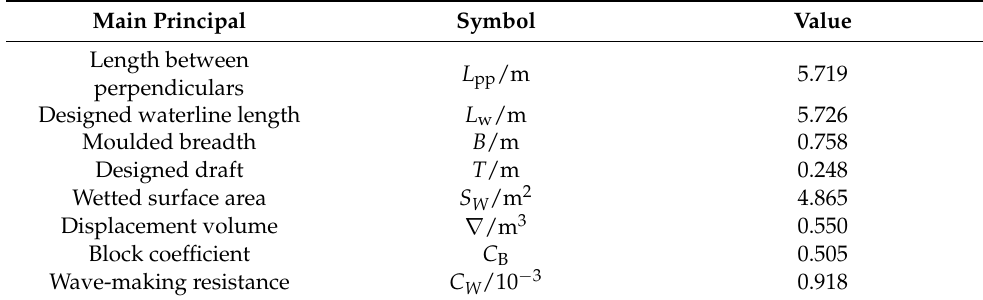
Table 3. The principal dimensions of the DTMB 5415 model.